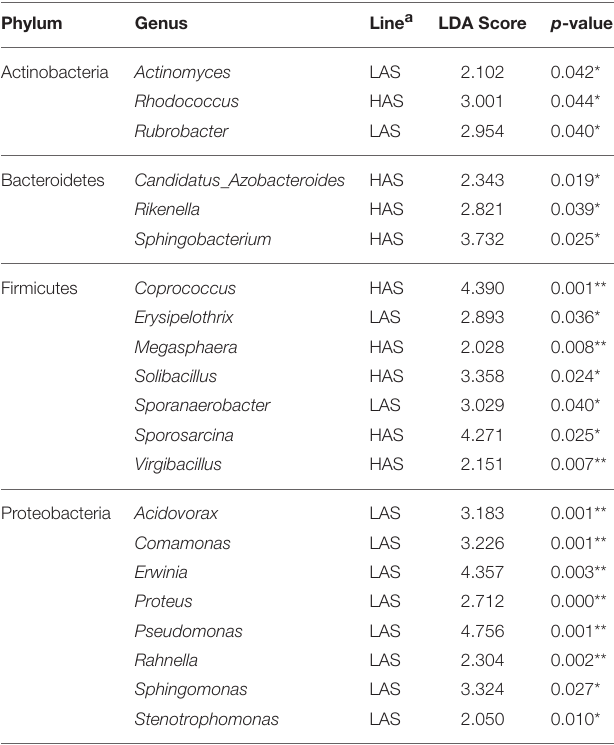
TABLE 1 | Relative abundance of microbiota at the genus level for HAS (high antibody selected) and LAS (low antibody selected) lines. Phylum Genus Line a LDA Score p